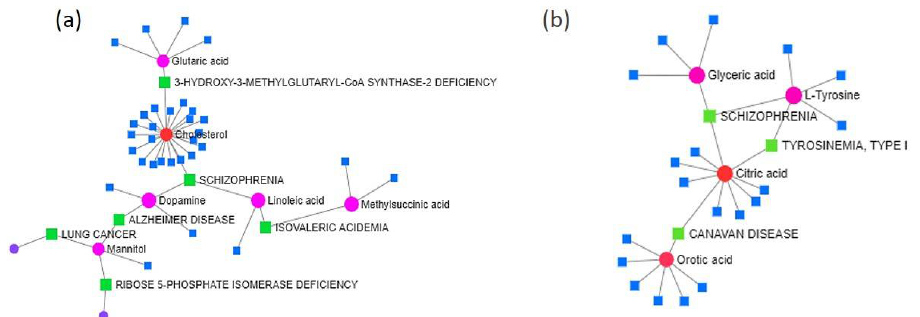
Figure 3. Metabolite–disease interaction network analysis of the top upregulated ( a ) and downreg- ulated ( b ) metabolites in Drosophila under a habanero-pepper diet. Enriched terms are represented as nodes, and the node size represents the significance for each term. Circles represent one metabo- lite and squares an associated disease.